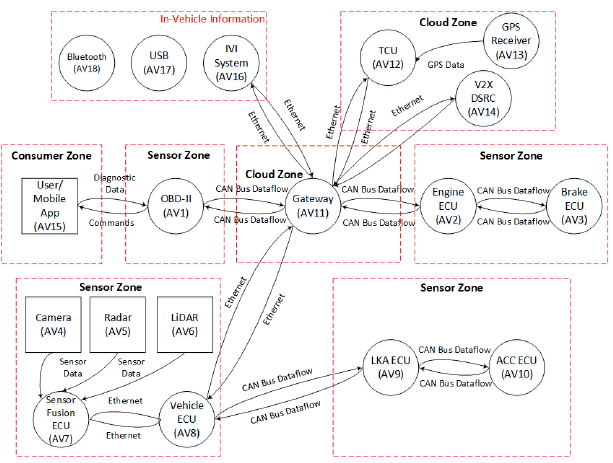
Figure 5. Data Flow Diagram (DFD) of Smart Autonomous Vehicular System (AVS).